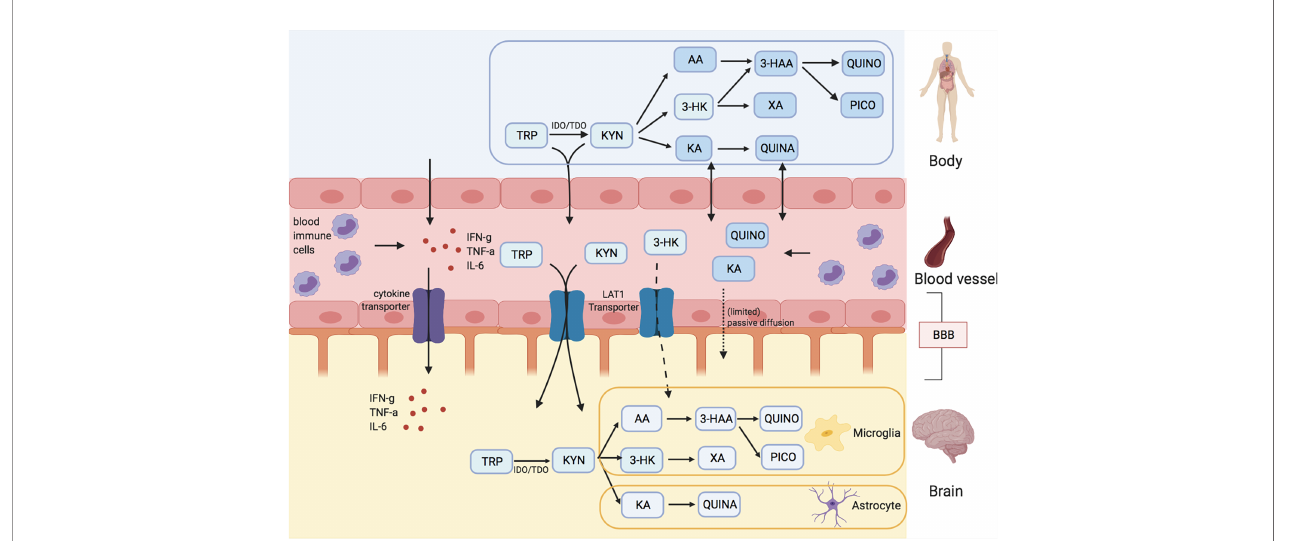
FIGURE 1 | Kynurenine metabolites and the blood brain barrier (BBB). Tryptophan (TRP) and kynurenine (KYN), and to a lesser degree 3-hydrox kynurenine (3-HK) are actively transported into the brain over LAT1 transporters. Downstream metabolites of the kynurenine pathway (KP), like quinolinic acid (QUINO) and kynurenic acid (KA), cannot make use of these transporters, but (probably limited) passive diffusion of these metabolites over the BBB is possible. Anthranilic acid and 3- hydroxy anthranilic acid (not shown in fi gure) may equally pass the blood brain barrier through passive diffusion, much like QUINO. In the brain, microglia are responsible for the production of metabolites 3-HK and QUINO, whereas astrocytes produce KA. Peripheral production of these KP metabolites is done by blood immune cells, such as blood monocytes (PBMC) and other organs, including liver and kidney. The gut microbiome, which plays a role in psychiatric illness through the gut-brain axis, also affects KP